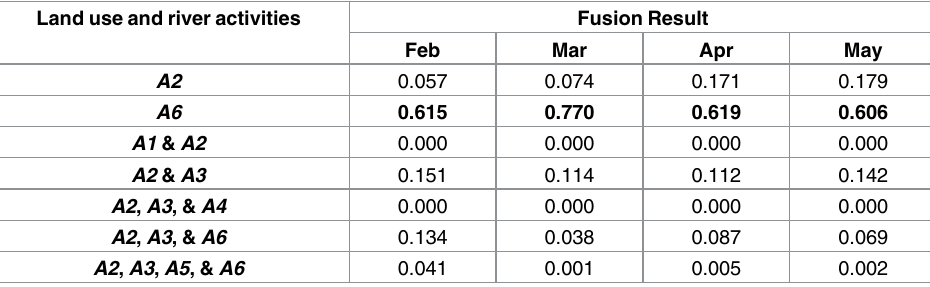
Table 8. Results of the application of the proposed